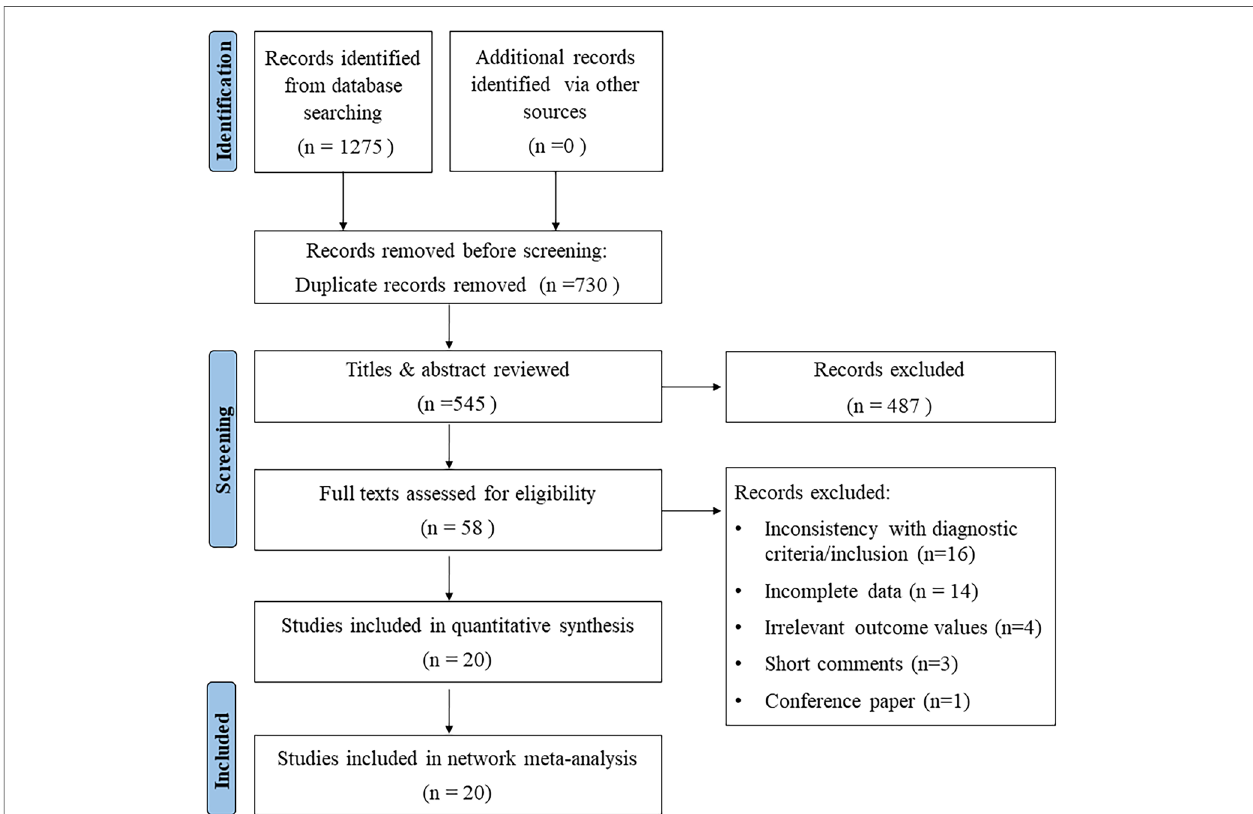
FIGURE 1 | Flow diagram of the study identi fi cation and selection